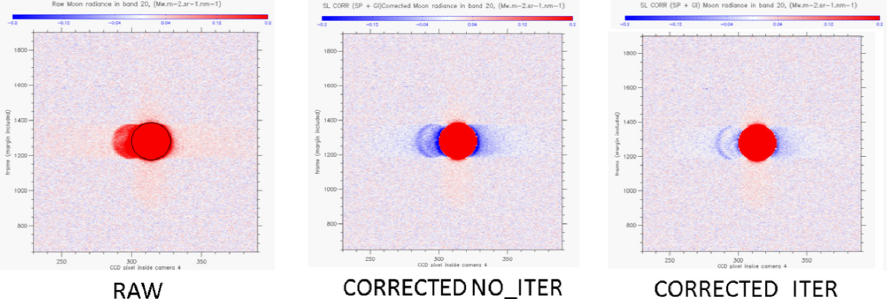
Figure 4. Oa20 moon radiance (left ) without stray-light correction, ( middle ) after nominal correction, ( right ) after correction using the iterative method. Color scale is linear, centered on zero (deep space value) and limited to stray-light radiance levels (i.e., the moon disk is saturated); red is for positive, white for close to 0, blue for negative radiance. On the left plot, a black circle has been drawn to visualize the moon disk better.